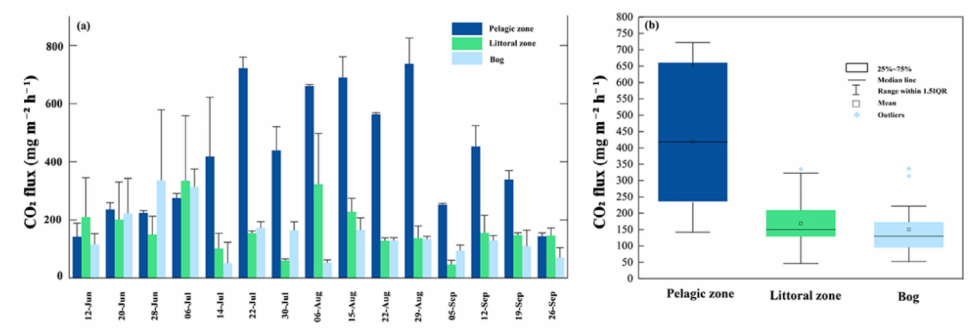
Figure 5. Temporal ( a ) and spatial ( b ) variation in CO 2 fluxes during the growing season. Bars represent mean ± SE. The empty squares, lines within each box, lower and upper edges and bars represent the means, median values, 25th and 75th, 10th, and 90th percentiles, respectively.